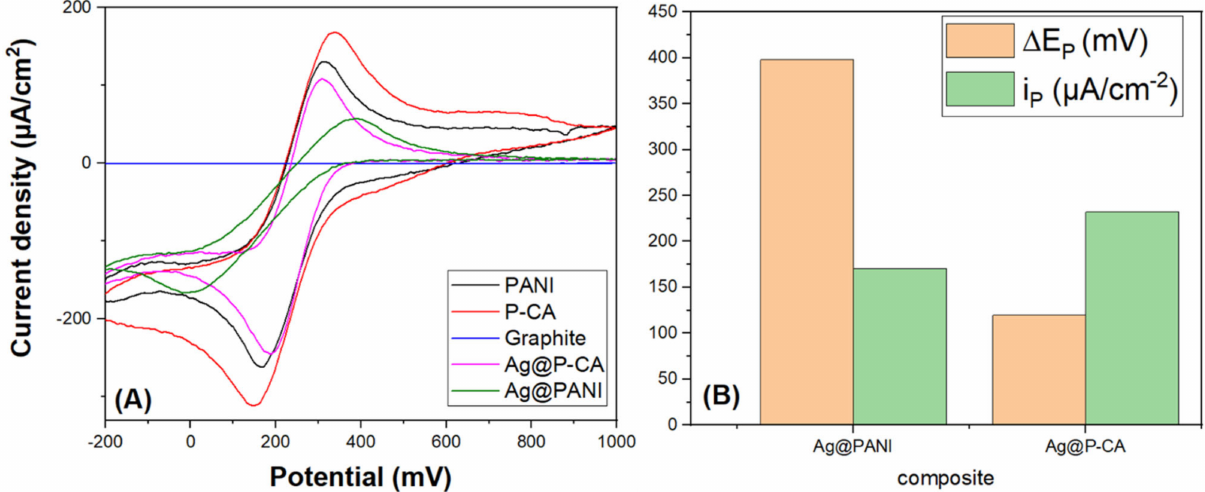
Figure 8. ( A ) CV analysis of modified PANI-based composites in a PBS-7 buffer solution containing 0.1 M of K 3 Fe(CN) 6 . ( B ) ∆ E p and maximum i p derived from ( A ). The CV analysis of synthesized ternary composites was carried out at a scan rate of 20 mV · s − 1 and a potential range from − 200 to 1000 mV using the three-electrode